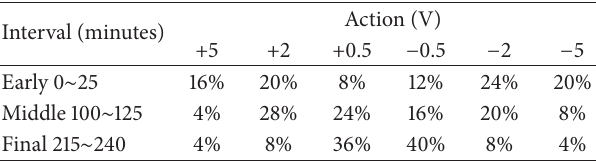
Table 1: The percentage of choosing action in different